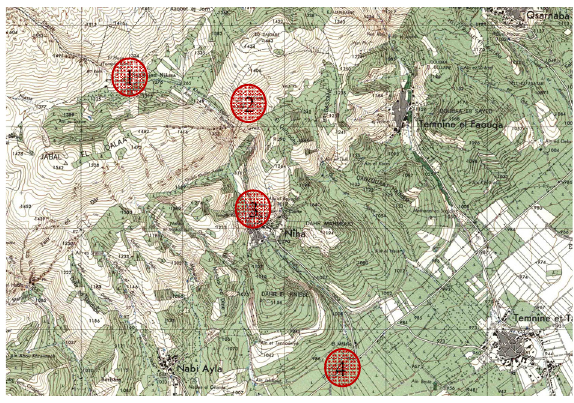
Figure 1. Zahle Map. Scale 1/20,000, © Direction de Affaires